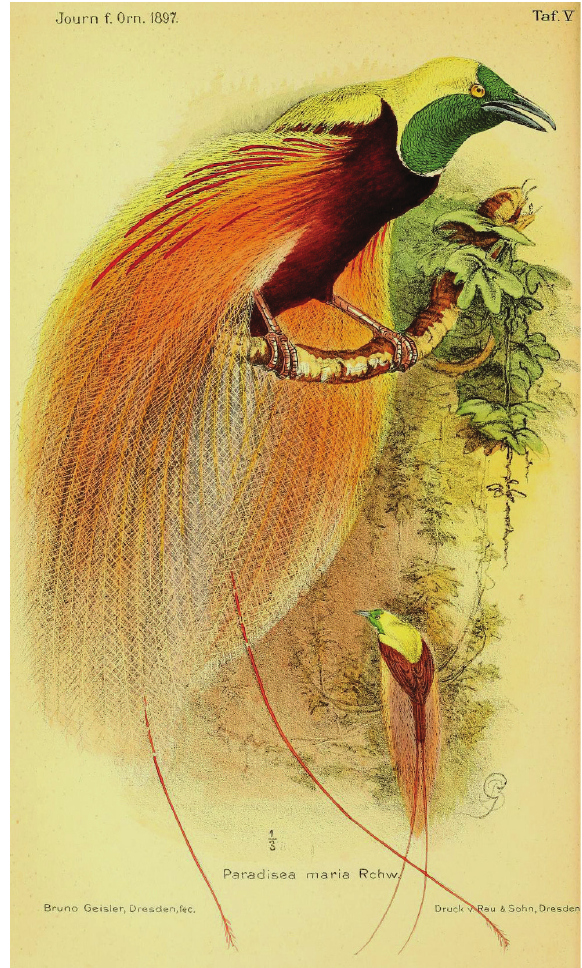
Figure 1. Plate of the male hybrid bird of paradise Paradisaea maria from Reichenow (1897). Reproduced from the Biodiver- sity heritage library